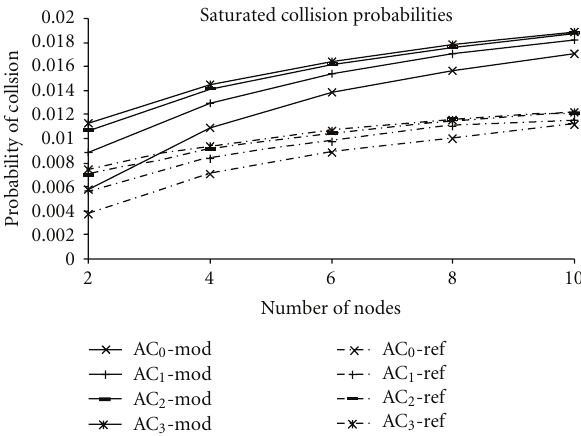
Figure 13: Probability of collision, basic